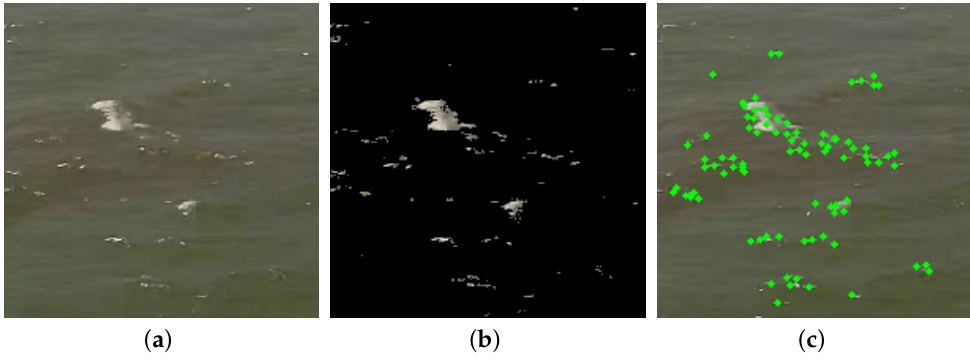
Figure 7. ( a ) Original image; ( b ) input image for Shi–Tomasi corner detection. ( c ) The features found by Shi–Tomasi corner detection.